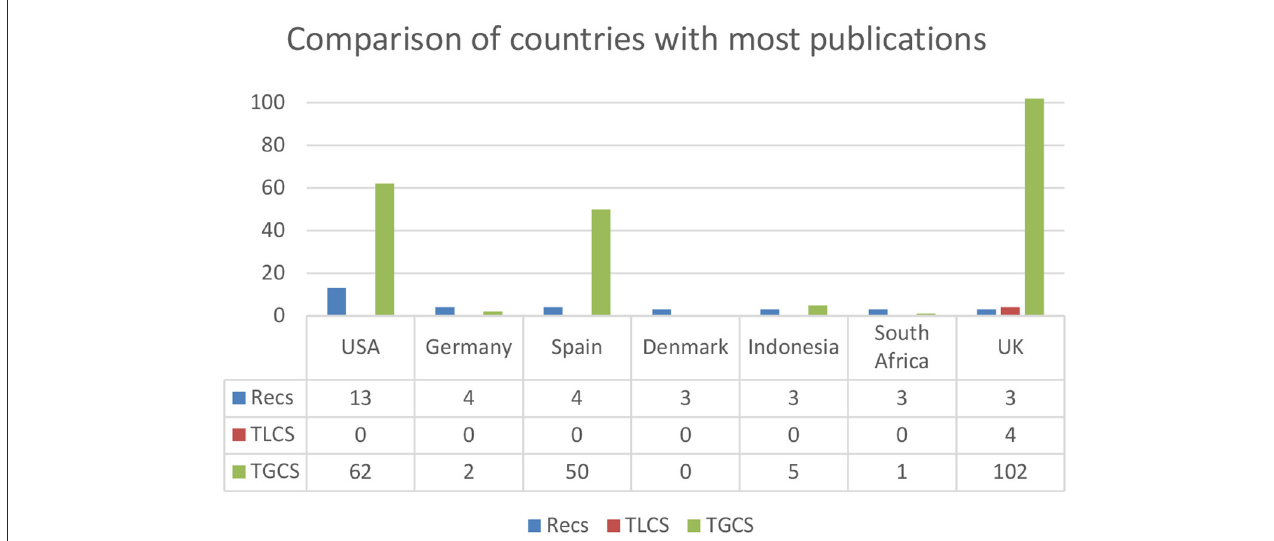
FIGURE4 Comparison of countries with the most publications ( ≥ 3 Recs). Recs, number of articles; TLCS, Local Citation Score; TGCS, Global Citation Score.